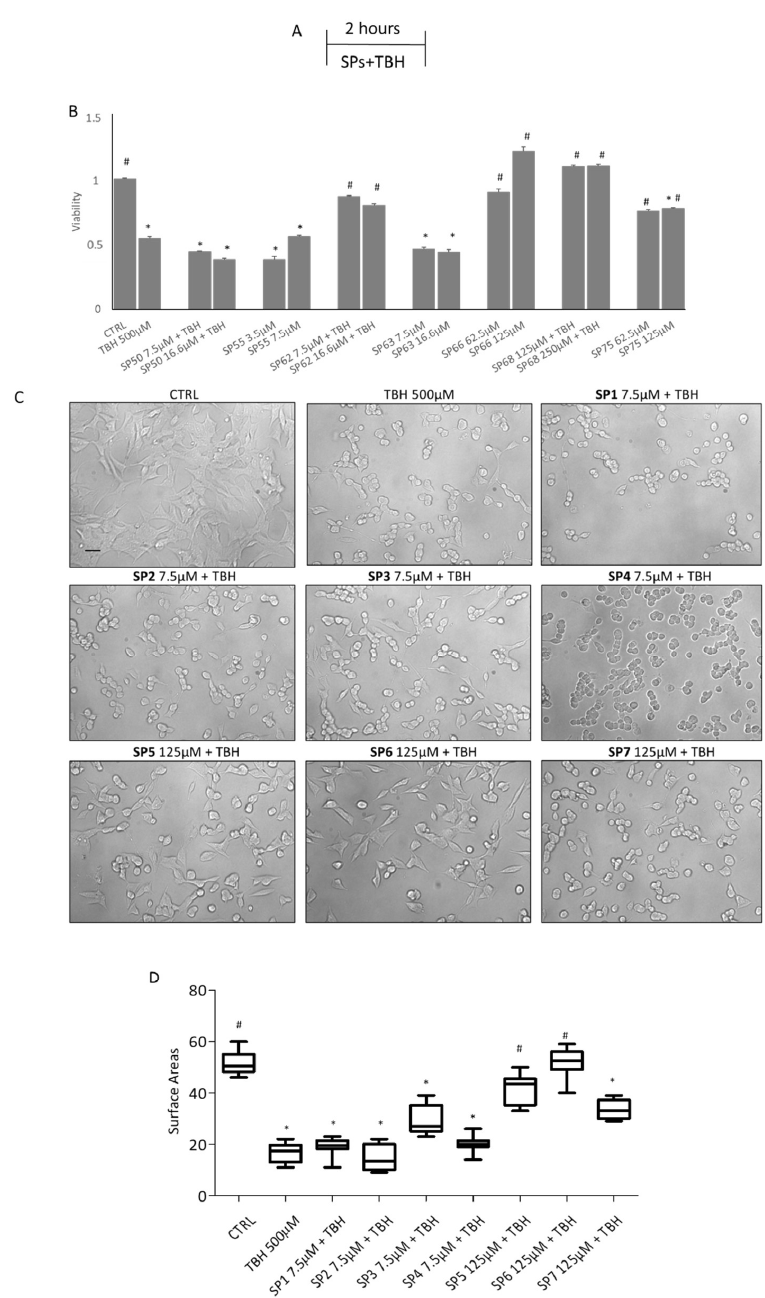
Figure 4. Antioxidant and protective effects of MITO compound treatment against TBH-induced oxidative stress. ( A ) Schematic representation of cotreatment with the MITO compounds. ( B ) MTS assay of cytoprotective effect of the MITO compounds cotreated with TBH (2 h, 500 µ M). ( C ) Repre- sentative morphological images. ( D ) Graphic of cellular body areas. Bar: 50 µ m. Tukey test: * p < 0.05 compared to CTRL group; # p < 0.01 compared to TBH